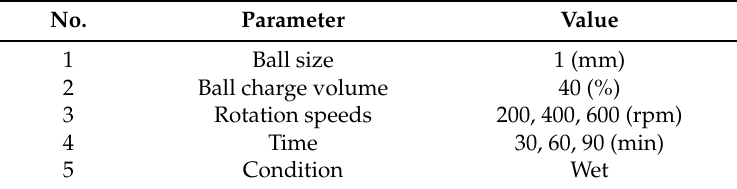
Table 1. Ball milling condition of graphene (GN).